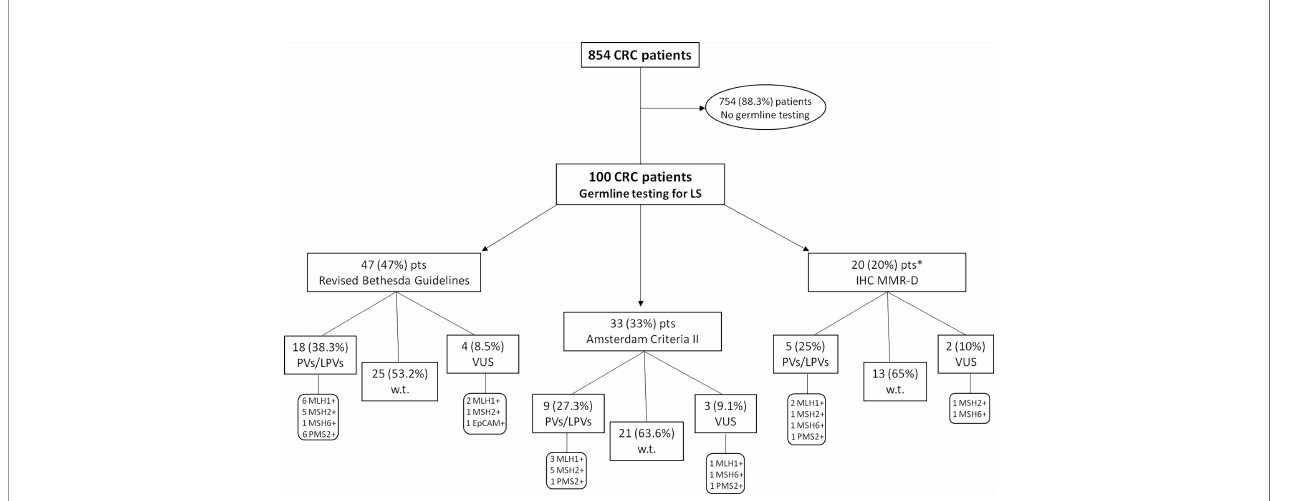
FIGURE 1 | Flow chart reporting the study design. One hundred CRC patients underwent genetic counseling and germline testing for MMR and EPCAM genes for suspected Lynch Syndrome, and divided into three subgroups on the basis of the following criteria: tumor MMR de fi ciency (detected through IHC), Amsterdam criteria II, and revised Bethesda guidelines. *This subgroup includes only IHC MLH1 -de fi cient patients negatively tested for somatic BRAF V600E mutation ( BRAF - wild-type ) and/or without MLH1 promoter hypermethylation. CRC, Colorectal Cancer; IHC, immunohistochemistry; MMR-D, Mismatch Repair De fi ciency; LPV, Likely Pathogenic Variant; Pts, Patients; PV, Pathogenic Variant; VUS, Variant of Uncertain Signi fi cance; w.t.,